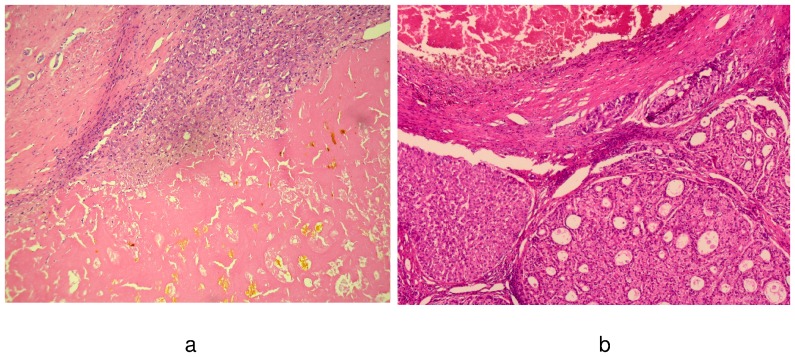
This figure demonstrates the micrographs (HE, 50×; 70×) of a post-IBT tumor responder with near complete postinterventional tumor necrosis (a), and of a tumor non-responder to IBT with necrotic tumor areas next to pseudoglandular HCC nodules (b), respectively.